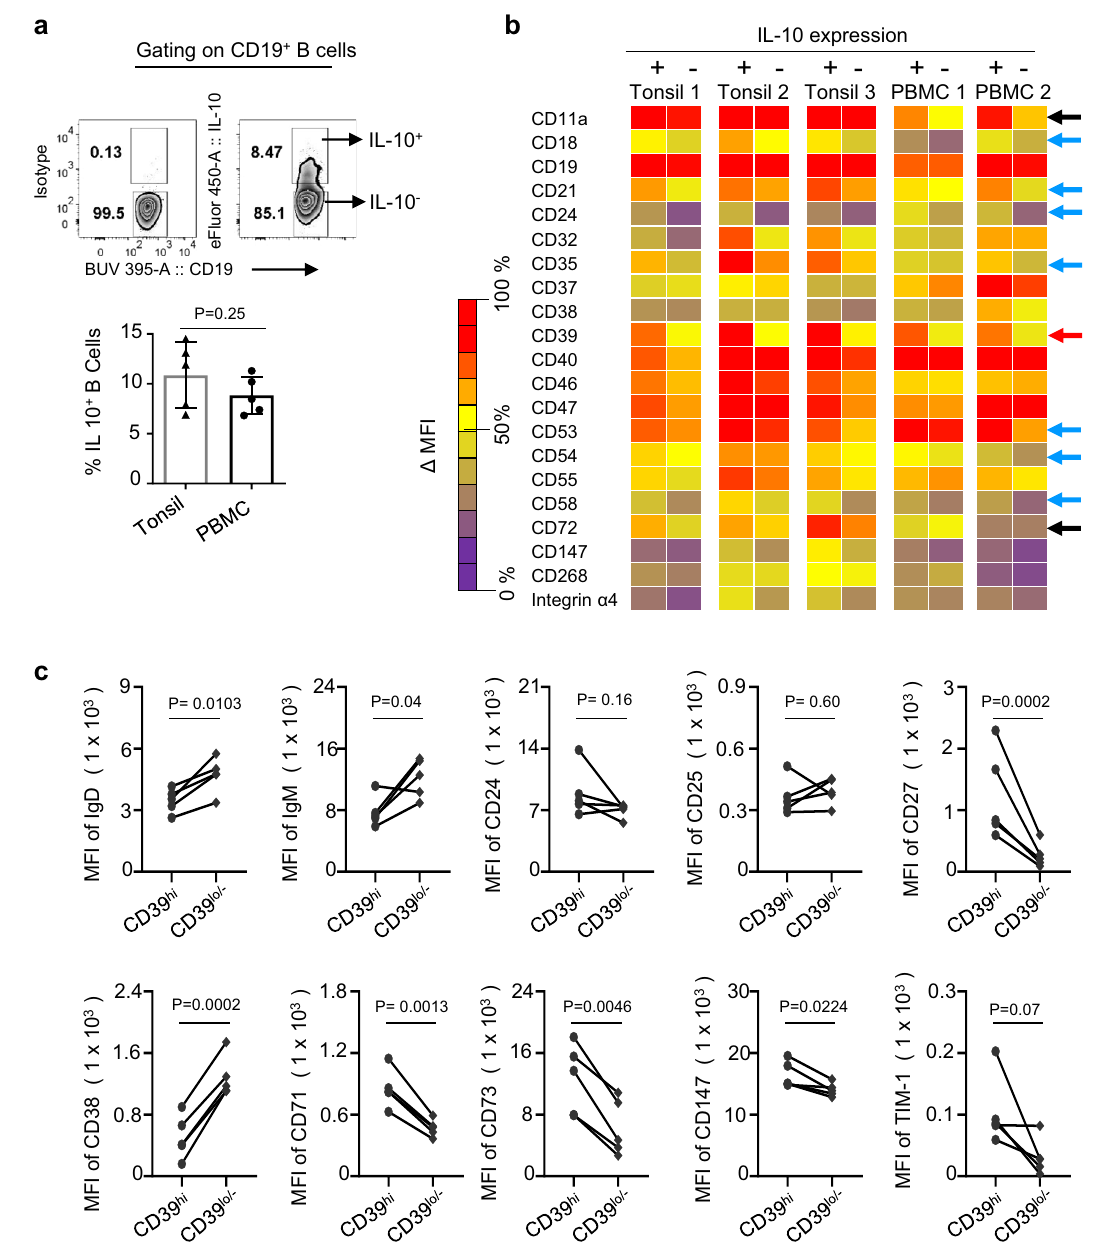
Fig. 1 CD39 expression is higher on IL-10 + B cells than IL-10 − B cells from tonsils and peripheral blood mononuclear cells. a A representative FACS plot showing IL-10 + and IL-10 − B cells in the blood of healthy subjects (upper panel). Cells were gated based on isotype antibody staining. Summarized data for the frequency of IL-10 + B cells (lower panel). Individual dots represent data generated with cells from different donors ( n = 5). b Summary of FACS array data. Heatmap illustrating the expression levels of various cell surface markers on IL-10 + and IL-10 − B cells. Tonsillar mononuclear cells (MNCs) and peripheral blood mononuclear cells (PBMCs) were stimulated with CpG-B for 48 h. PMA/ionomycin, brefeldin A, and monensin cocktails were added for the last 5 h of the culture. Cells were stained with antibodies speci fi c for cell surface molecules. Cells were then stained for intracellular IL-10 expression. Mean fl orescence intensity (MFI) was acquired upon subtracting isotype control. Cell surface markers with Δ MFI ≥ 500 between IL-10 + and IL-10 − B cells are presented. The colored scale shows the expression level ( Δ MFI) of each cell surface markers on IL-10 + and IL-10 − B cells. Purple ( Δ MFI > 25% by rank), yellow ( Δ MFI = 25 – 65% by rank), and red ( Δ MFI < 65% by rank) colors were used to indicate low to high level of expression. c MFI values of surface IgD, IgM, CD24, CD25, CD27, CD38, CD71, CD73, CD147, and TIM-1 on CD39 high and CD39 low/ − B cells. Cells were stained without activation. Data generated with cells from different healthy subjects ( n = 5) were combined. Error bars are mean ± SD in a . P values were determined with a two-tailed unpaired t test in a and a paired t test in c